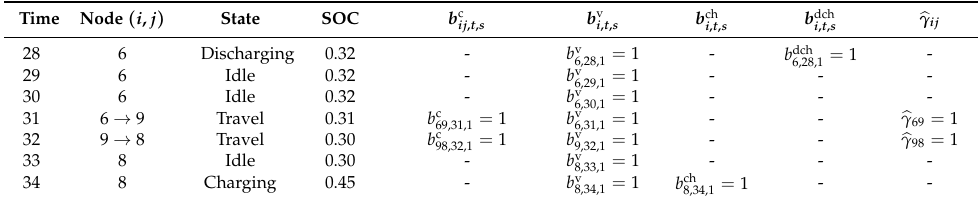
Table 1. Schedule for the routing and charging/discharging of MCS1 during the scheduling period